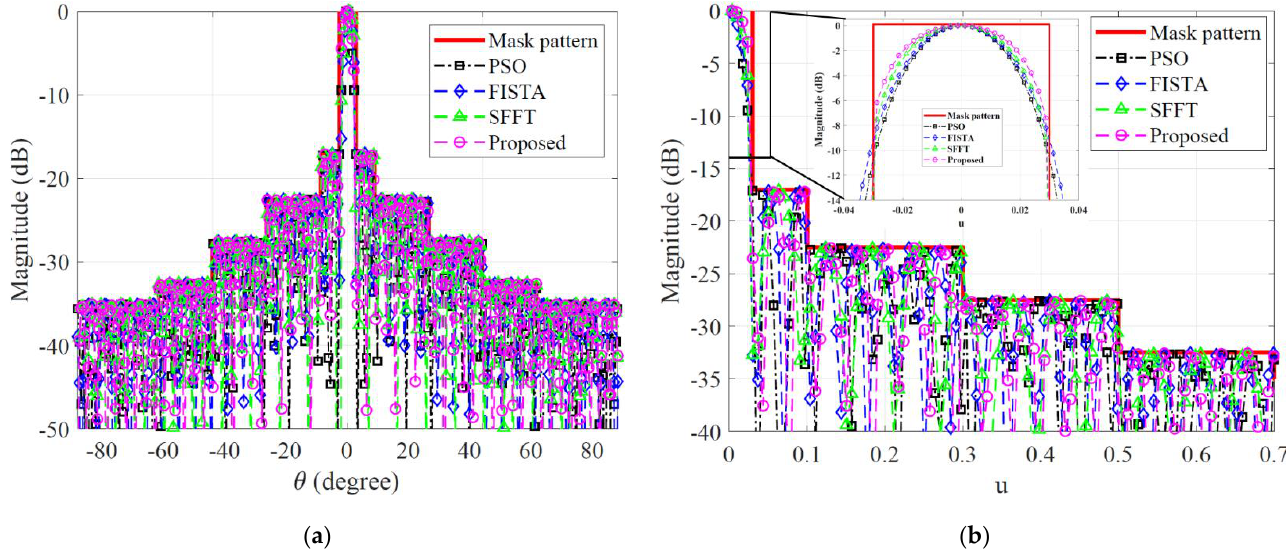
Figure 3. Desired AFs synthesized with K = 300 array elements for desired beamwidth τ M = 0.06 (rad), and the comparison between the proposed method and optimization techniques; ( a ) Full angle range; ( b ) Sector beam patterns.